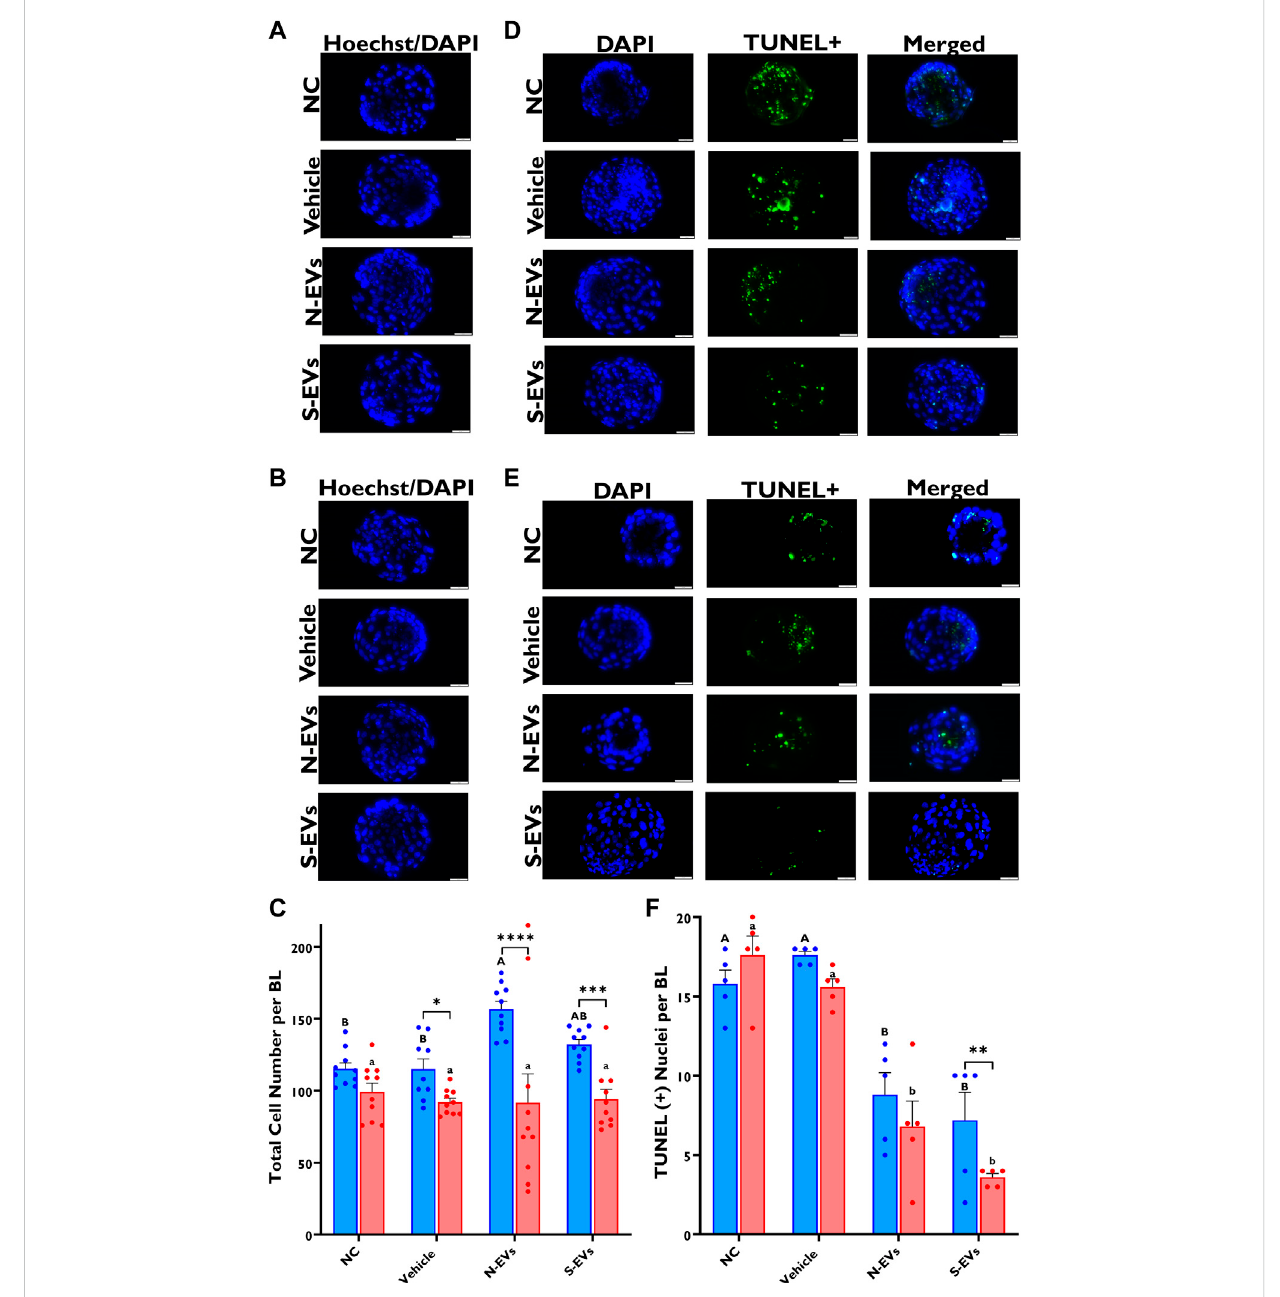
FIGURE 9 The bene fi cial effect of GC-EV supplementation during in vitro maturation on blastocyst quality under in vitro normal physiological (38.5 ° C; blue) andHS(41 ° C;red)conditions.Fluorescenceimagesof invitro culturedbovineblastocyststreatedwithHoechst33342/DAPIwereusedtodeterminetotal cell numbers in preimplantation embryos. Scale bar, 50 µM [38.5 ° C; (A) ] [41 ° C; (B) ]. Quanti fi cation of total cell numbers in single blastocysts were carried out in triplicates (a total of 18 – 30 blastocysts per treatment) (C) . Fluorescence images of in vitro cultured bovine blastocysts subjected to a TUNEL assaywerecapturedforspeci fi cdetectionofapoptoticcells.Scalebar,50 µM[38.5 ° C; (D) ][41 ° C; (E) ].Quanti fi cationofTUNEL+cellsinsingleblastocysts were carried out in triplicates (a total of 19 – 41 blastocysts per treatment) (F) . Data among treatments represent the mean ± SEM and the differences between means were analyzed using Two-way ANOVA followed by Tukey ’ s Multiple Comparisons Test. Bars with different letters (38.5 ° C; uppercase) (41 ° C;lowercase)indicatestatisticallysigni fi cantdifferencesofatleast( p < 0.05)betweentreatmentsunderthesamecultureconditions,while(*)indicate statistical differences between the same treatment under different culture environments during IVM (* p < 0.05), (** p < 0.01), (*** p < 0.001), (**** p <